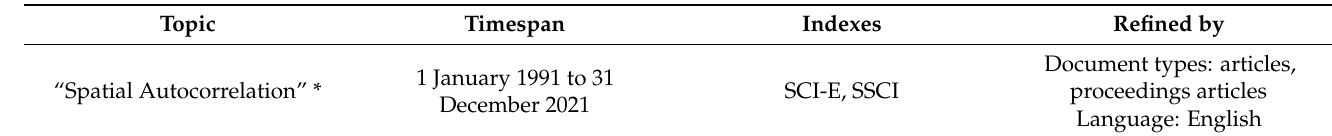
Table 1. Bibliography search